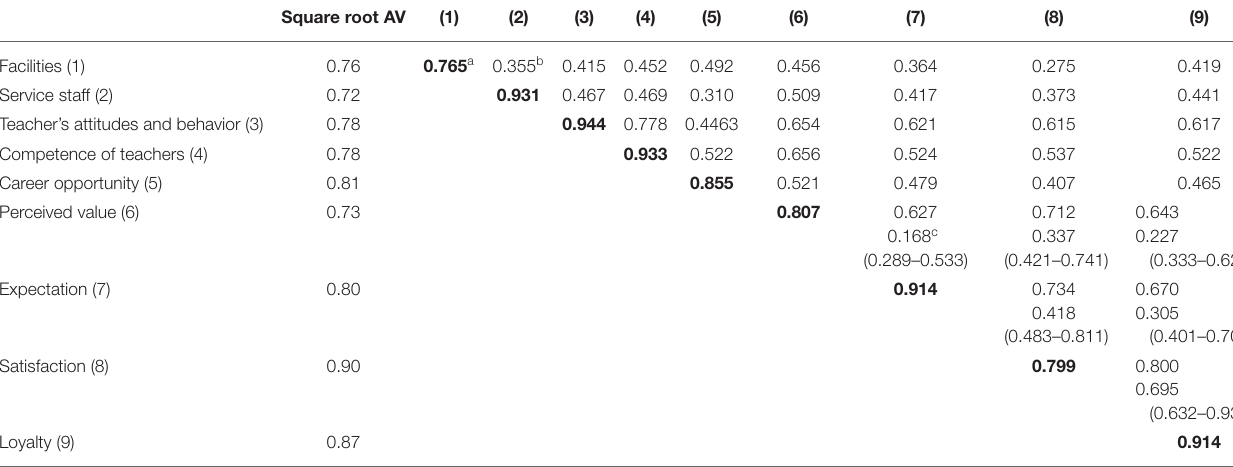
TABLE 4 | Correlation matrix and discriminant